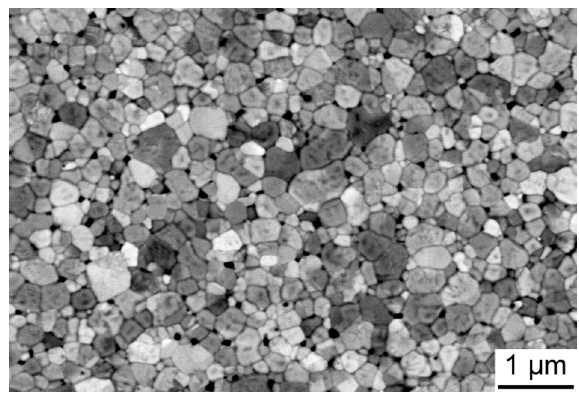
Figure 5. SEM image of a thermally etched surface of the (3Y)-TZP PSZ layer.